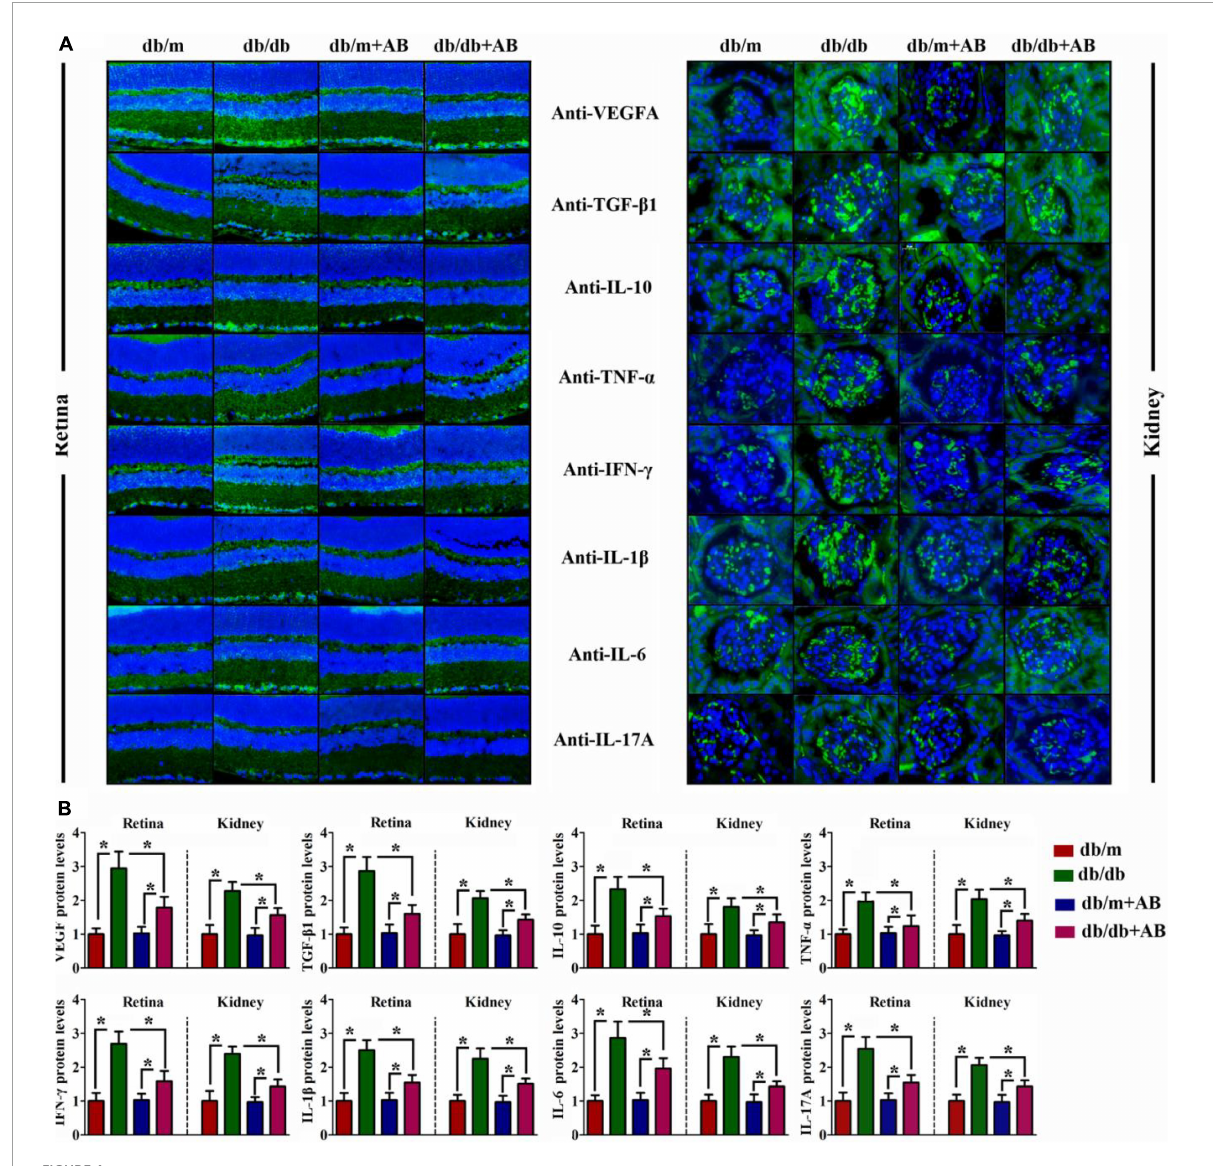
FIGURE4 Obesity promoted local inflammation in retina and kidney. Representative immunofluorescence images of retina ( A , Left) and kidney ( A , Right) tissues stained with VEGFA, TGF- β 1, IL-10, TNF- α , IFN- γ , IL-1 β , IL-6, and IL-17A antibodies in db/db and db/m mice, which were treated with vehicle or with antibiotic. The relative quantitative analyses are presented in (B) . Bar = 50 µ m. Data are expressed as the means ± S.D., n = 8 in per group. * P <